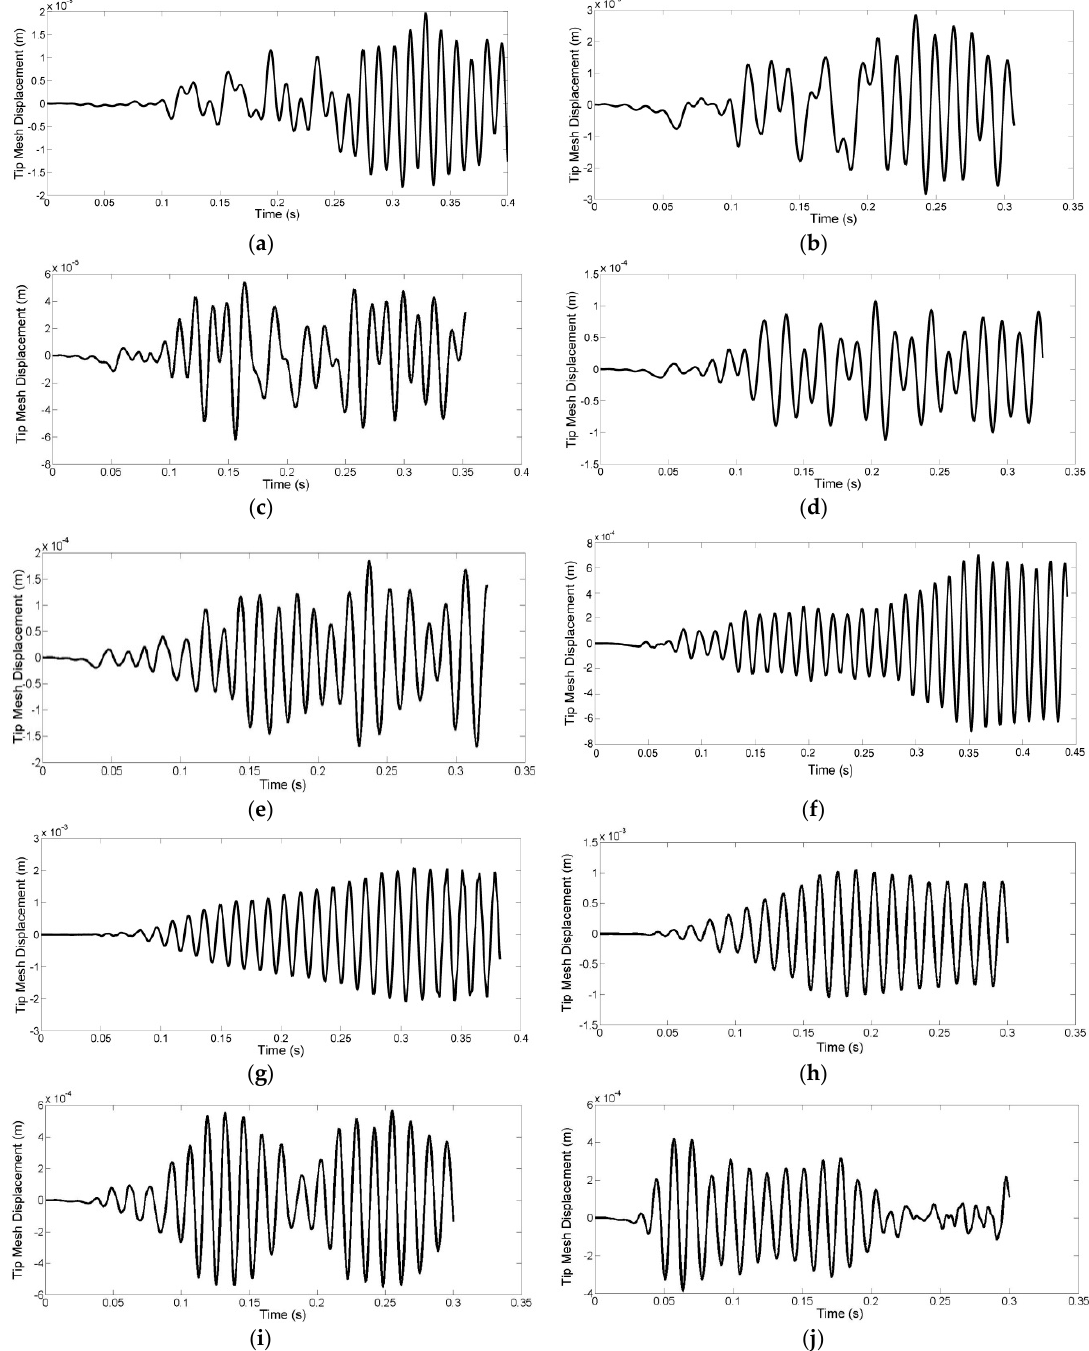
Figure 17. Graph tip mesh displacement (m) against time (s); ( a ) 7 m/s; ( b ) 10 m/s; ( c ) 12 m/s; ( d ) 14 m/s; ( e ) 16 m/s; ( f ) 18 m/s; ( g ) 19 m/s; ( h ) 20 m/s; ( i ) 22.5 m/s; ( j ) 25 m/s.